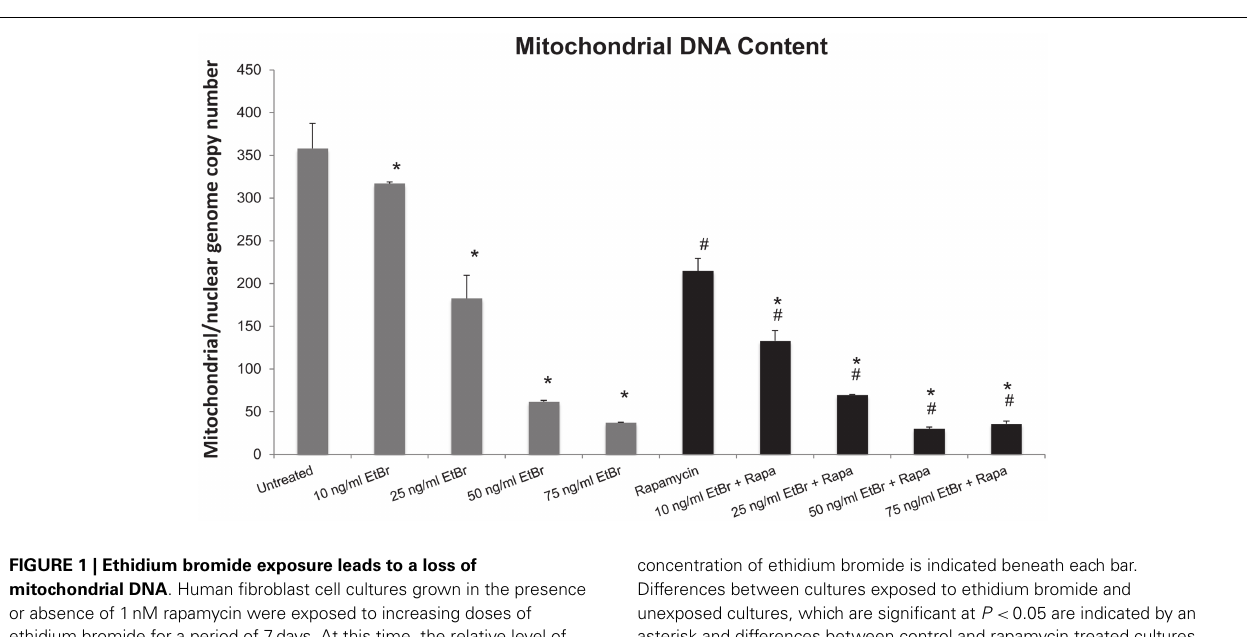
FIGURE 1 | Ethidium bromide exposure leads to a loss of mitochondrial DNA . Human fibroblast cell cultures grown in the presence or absence of 1nM rapamycin were exposed to increasing doses of ethidium bromide for a period of 7days. At this time, the relative level of mitochondrial DNA was assessed using real-time PCR analysis as described in Section “Materials and Methods.” Gray bars indicate control cultures and black bars indicate rapamycin treated cultures.The